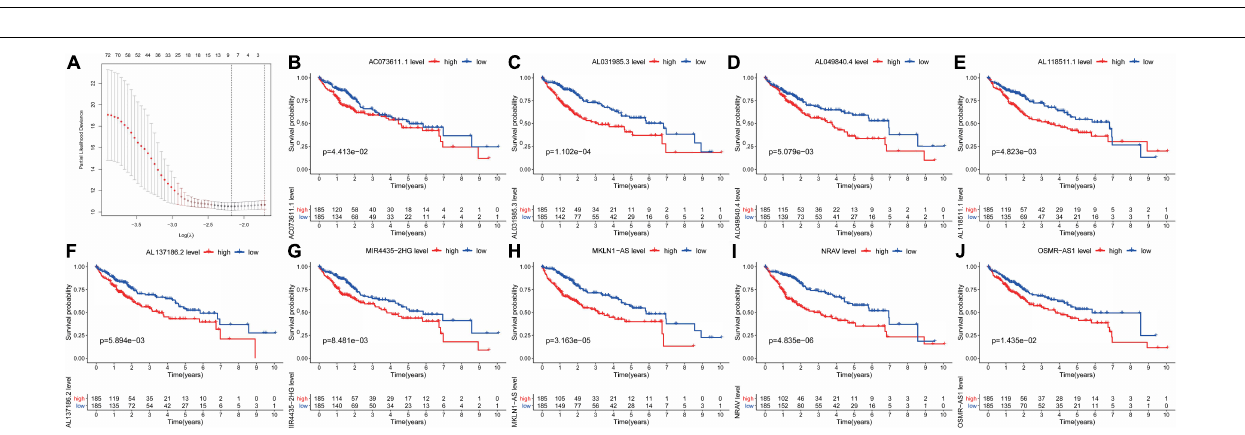
Frontiers in Cell and Developmental Biology |